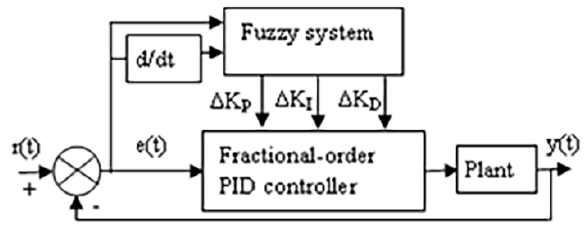
Figure 3. FFOPID control structure block diagram.